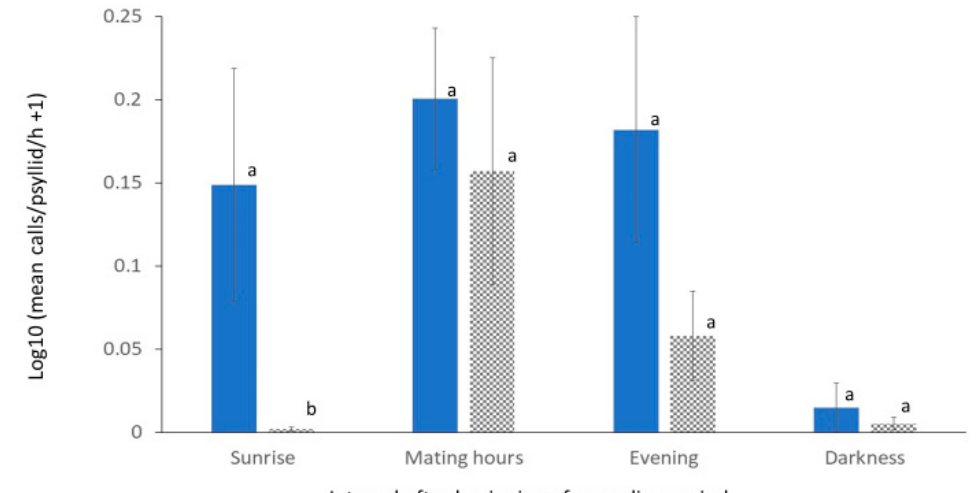
Figure 5. Log10-transformed means and standard errors (SEs) of the number of vibrational calls/psyllid/h detected over time after sunrise in tests with 5 (solid bar) or 25 (checkered bar) D. citri female and males released onto small citrus trees. Interval time periods were sunrise: 06–10:00, mating hours: 10–16:00, evening: 16–20:00, and darkness: 20–22:00. The SE are marked by capped-lines. Call rates in each recording period interval marked with the same letter are not significantly different ( p > 0.05 in a Tukey HSD test).